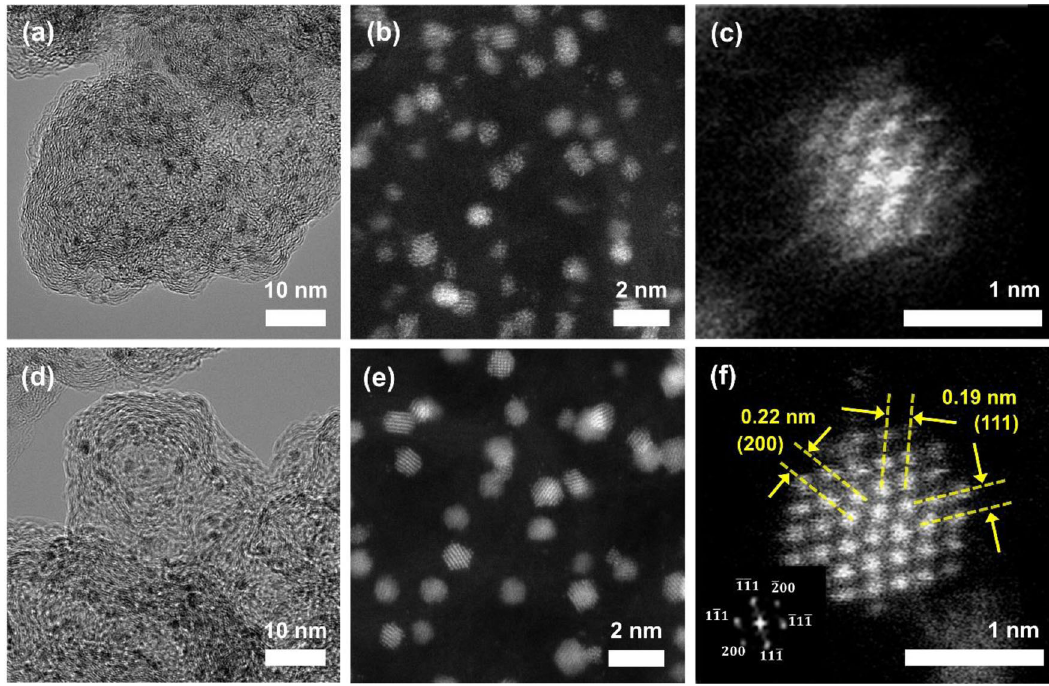
Fig. 1 Morphological and structural characteristics of the synthesized IrNi nanoparticles supported on carbon at different heat-treatment temperatures of 400 °C and 1000 °C, which are denoted as IrNi/C-LT and IrNi/C-HT, respectively. a TEM and b , c HADDF images of IrNi/C-LT. d TEM and e , f HADDF images of IrNi/C-HT. The inserted fast Fourier transform of the IrNi/C-HT particles show the (111) and (200)